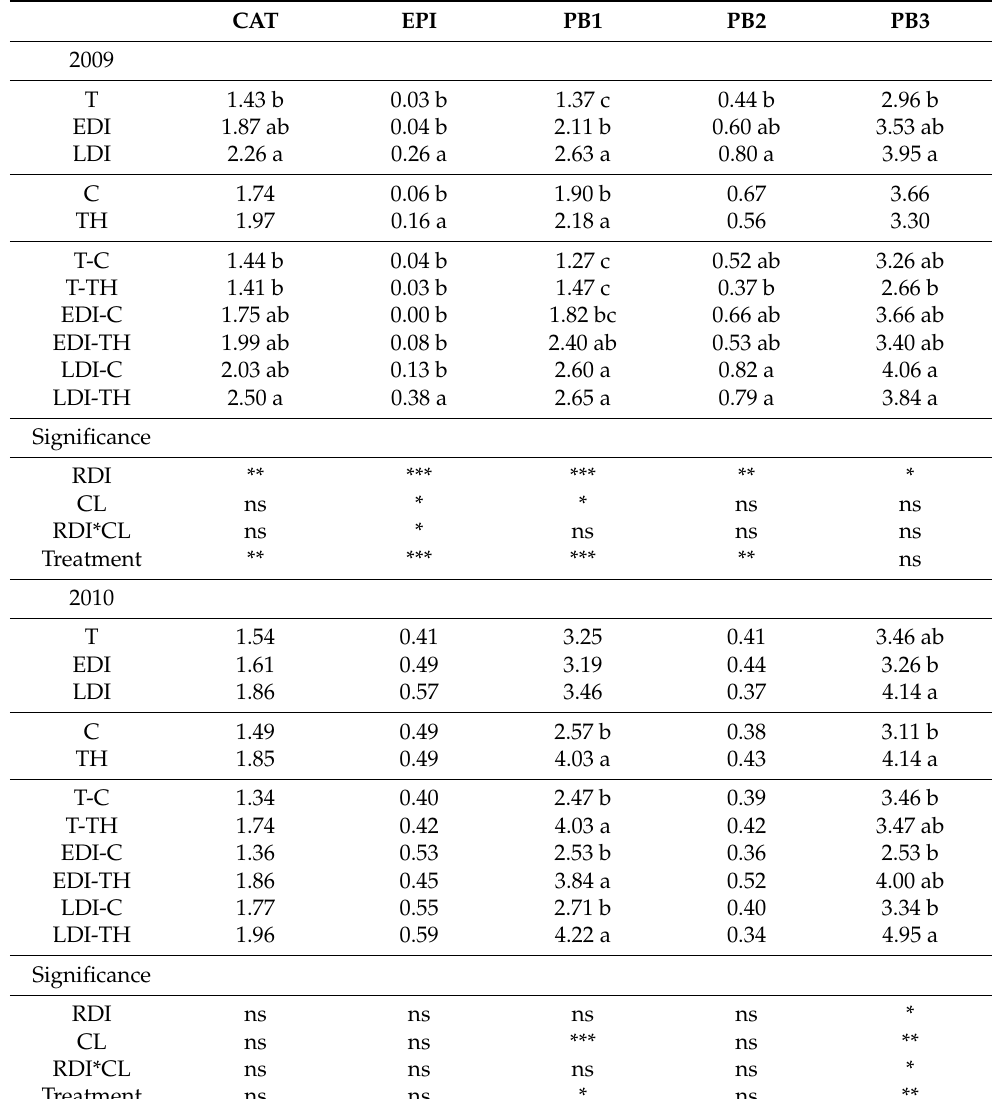
Table 3. Effects of regulated deficit irrigation and cluster thinning on grape skin flavanol concentration (mg/kg berry fresh weight) in 2009 and